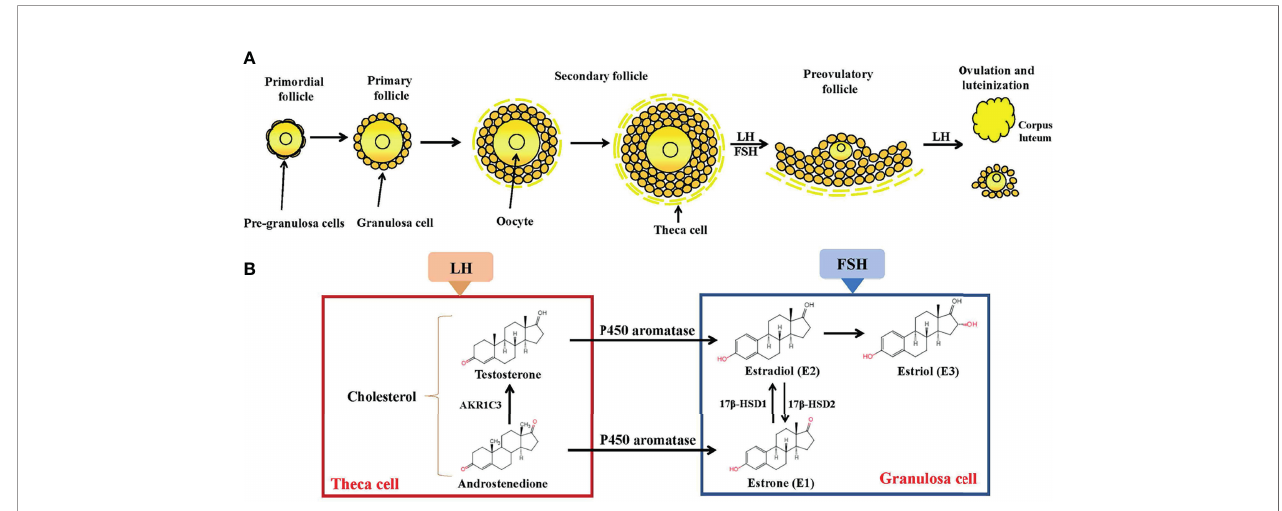
FIGURE 1 | Folliculogenesis and follicular estrogen synthesis. (A) Estrogen biosynthesis in ovarian follicles is known as the ‘ two-cell-two-gonadotropin system ’ because both cells (granulosa and theca cells) and gonadotropins (FSH and LH) are indispensable for the generation of estrogen in ovarian follicles. Follicles are mainly composed of oocytes, granulosa cells and theca cells. Folliculogenesis develops from primordial, primary, secondary follicles and preovulatory follicles before ovulation occurs. After ovulation, the corpus luteum activity was restored. (B) Synthesis of estrogen. In theca cells, LH stimulation produces androstenedione and testosterone. In granulosa cells, testosterone is converted by P450aromatase into estradiol. LH, Luteinizing Hormone; FSH, follicle stimulating hormone; AKR1C3, aldo-keto reductase 1C3; 17 b - HSD, 17 b -hydroxysteroid